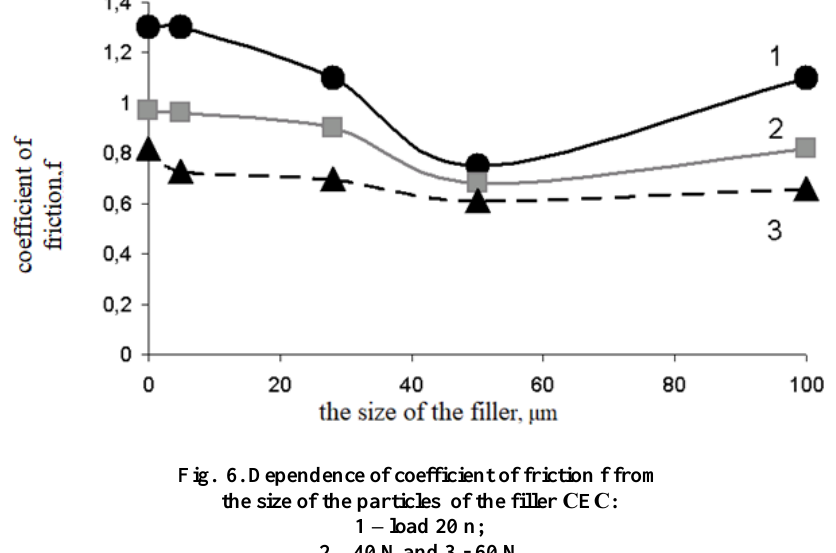
Fig. 6. Dependence of coefficient of friction f